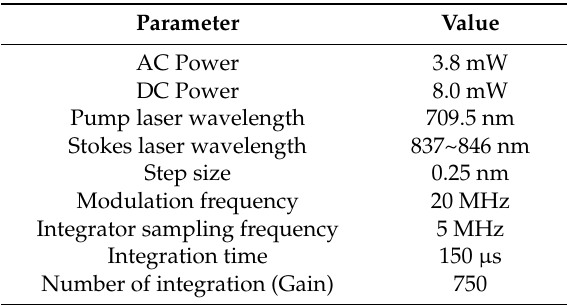
Figure 15. Photograph of the measurement setup for SRS.